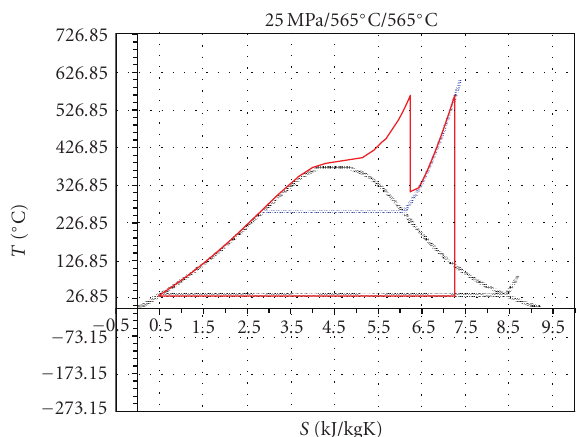
Figure 2: Ideal T - S diagram of once-reheat SC Rankine cycle with 25 MPa/565 ◦ C/565 ◦